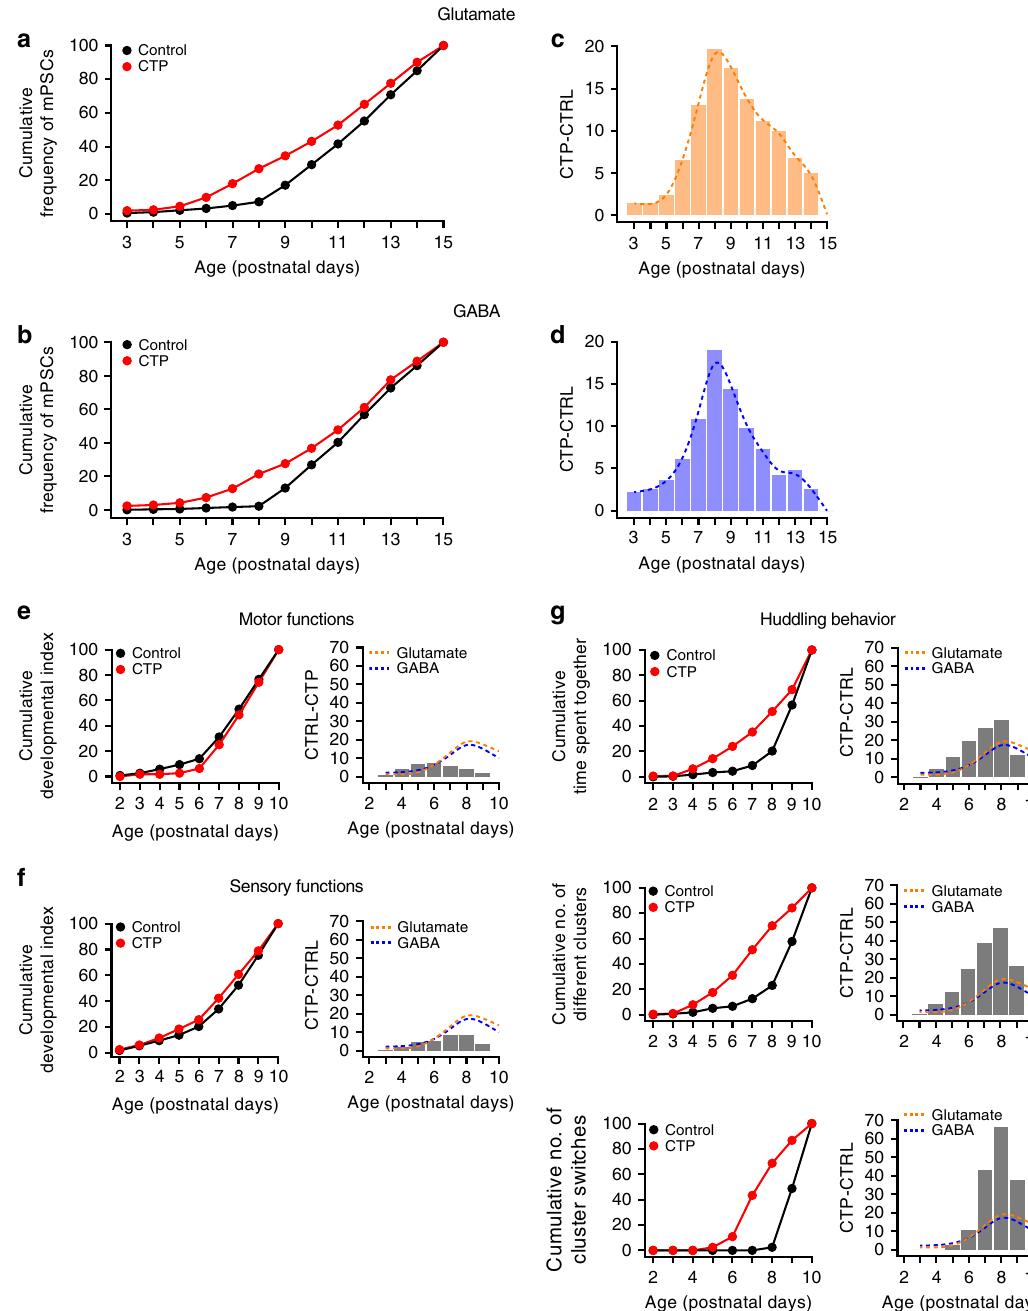
Fig. 4 Blockade of 5-HT reuptake at early postnatal ages in vivo anticipates the temporal development of synaptic currents and the onset of huddling. a , b Cumulative developmental curves of the average frequencies of glutamatergic ( a ) and GABAergic ( b ) mPSCs from animals that were treated systemically with CTP (red, N = 86 cells from 13 animals) vs controls black traces (from Fig. 1b). c , d Bar plot showing the difference between the CTP and control cumulative curves for each postnatal day; dashed lines represent the polynomial fi t of the difference distribution of glutamatergic (orange) and GABAergic (blue) mPSCs. The maximal separation between the control and the CTP cumulative curves was observed at P8 both for glutamatergic and GABAergic mPSCs. e , f Left panels: Cumulative developmental curves of motor and sensory functions. The CTP treatment did not alter the time course of the onset of motor and sensory functions (statistical interaction between the factors ‘ treatment ’ and ‘ postnatal age ’ after a two-way ANOVA of ranks was not signi fi cant for motor (F (8,108) = 0.29, P > 0.05) and sensory functions (F (8,198) = 0.87, P > 0.05); N = 5 litters, 50 animals total for CTP, and data for control from Fig. 2b). In ( e ), values from control were subtracted from CTP values to obtain positive differences. The cumulative curve for controls was calculated from the data presented in Fig. 2b. Right panel: bar plot showing the difference between the CTP and control cumulative curves for each postnatal day (gray bars). Bar plots were overlapped to dashed lines representing the differences observed for glutamatergic and GABAergic mPSC curves calculated in c and d for direct comparison. g Same as e and f , but for the three parameters describing the huddling behavior. For all parameters, the maximal difference between cumulative curves was observed at P8. Dotted lines represented the curves in c and d reported for direct